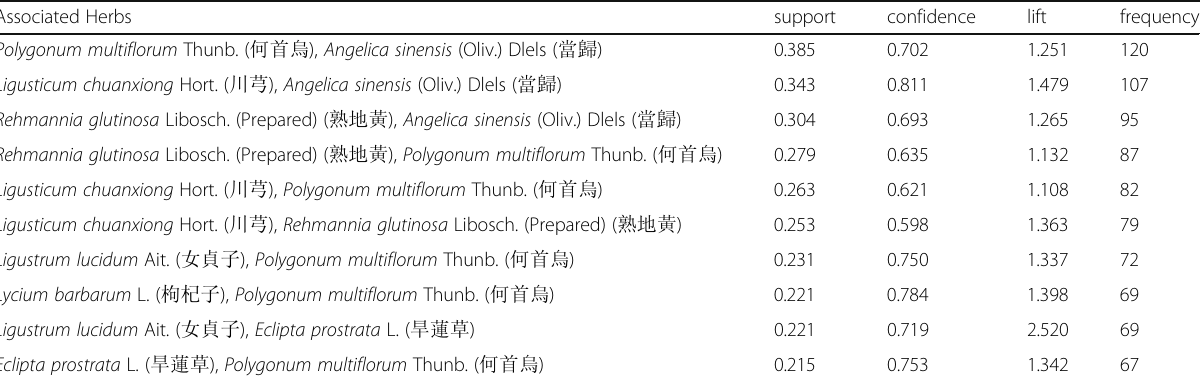
Table 2 Association rule mining results (Length of herb set = 2) Associated Herbs support